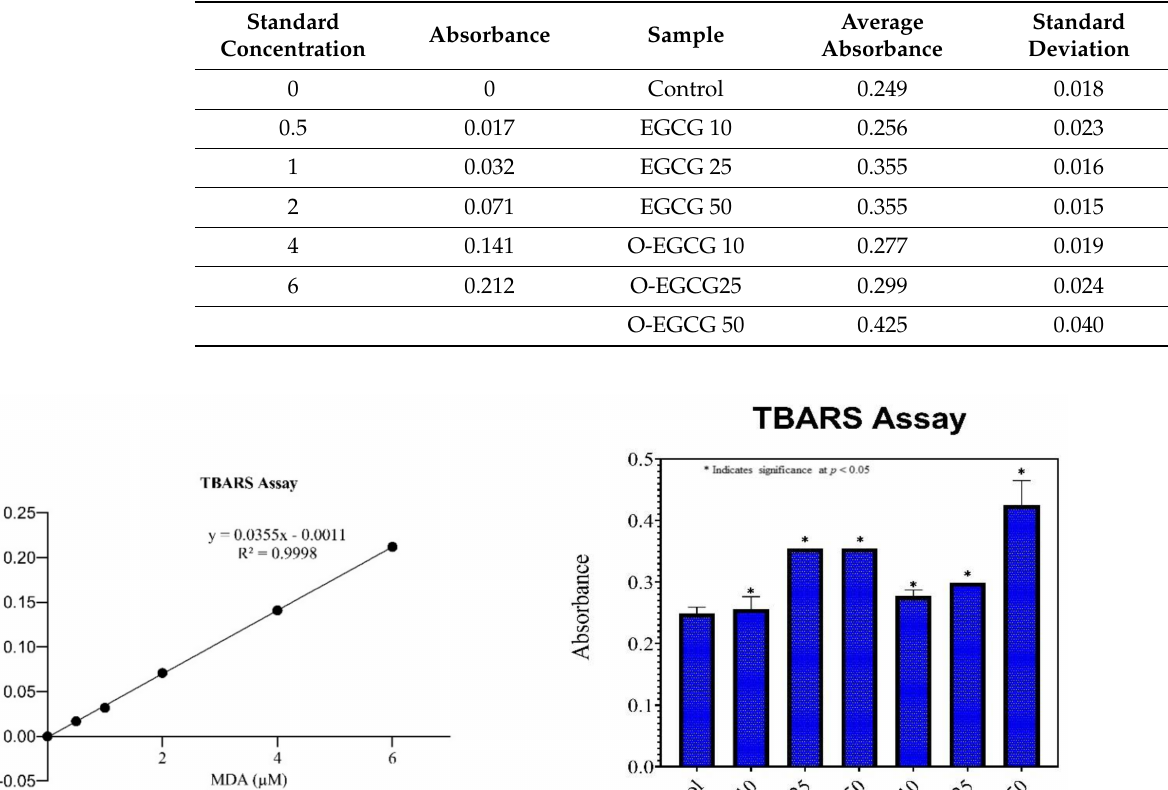
Table 3. Effect of EGCG on lipid peroxidation (TBARS formation).